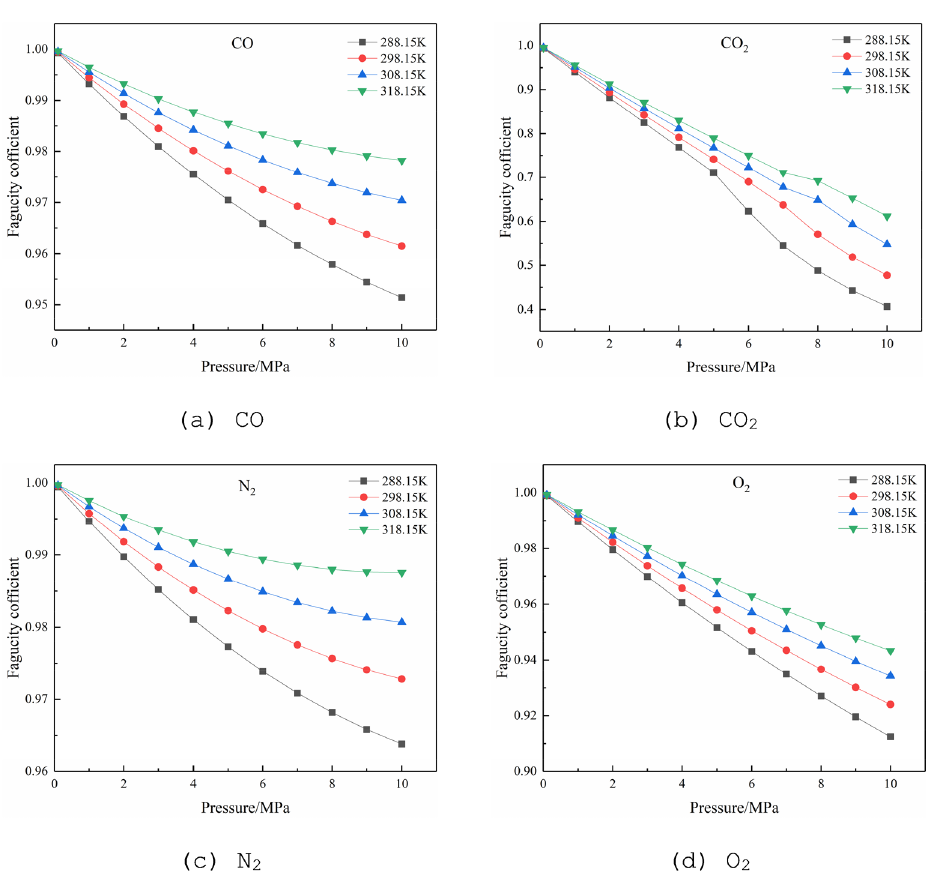
Figure 3. The relationship between the fugacity coefficient and pressure of single-components at different